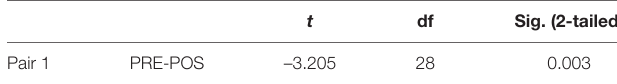
TABLE 9 | Pair samples test of the experimental group.